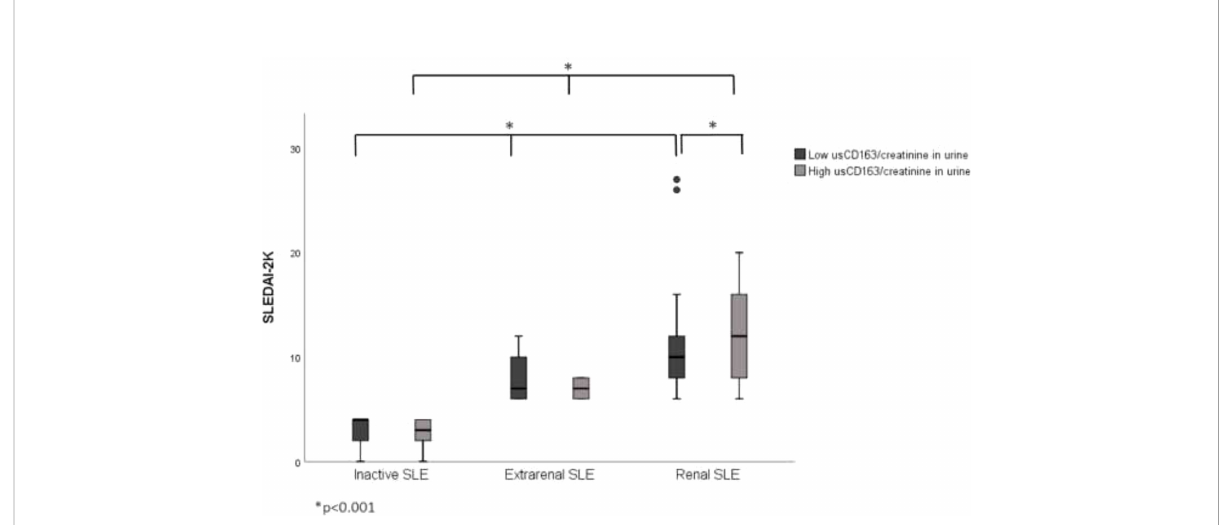
FIGURE 2 Correlation between usCD163/creatinine in urine and SLEDAI-2K in SLE patients. The renal SLE patients with high usCD163/creatinine ratios had higher SLEDAI-2K scores compared with those with low usCD163 levels. However, no difference in SLEDAI-2K score was seen between the inactive and extrarenal SLE patients. SLEDAI-2k, Systemic Lupus Erythematosus Disease Activity Index